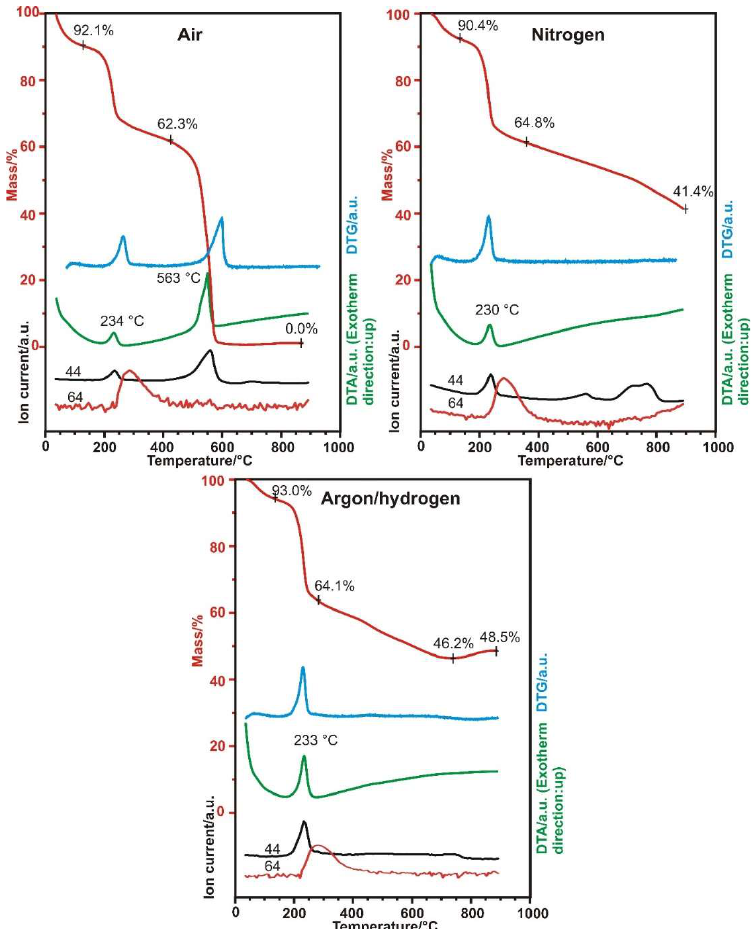
Figure 1. TG/DTA-MS measurements of the GO in different atmospheres to 900 °C (red: TG, blue: Figure 1. TG / DTA-MS measurements of the GO in di ff erent atmospheres to 900 ◦ C (red: TG, blue: DTG, DTG, green: DTA, ion currents: black: 44 m/z, red: 64 m/z). green: DTA, ion currents: black: 44 m / z, red: 64 m /